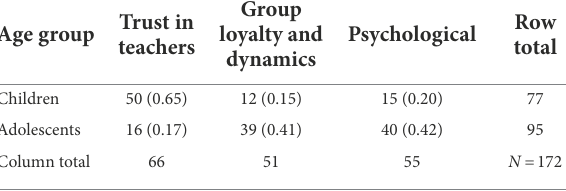
Observed values are reported with proportions within group in brackets. TABLE 5 Frequencies and proportions of participants’ reasoning of getting help from a friend as a function of age group. Trust in Age group friends